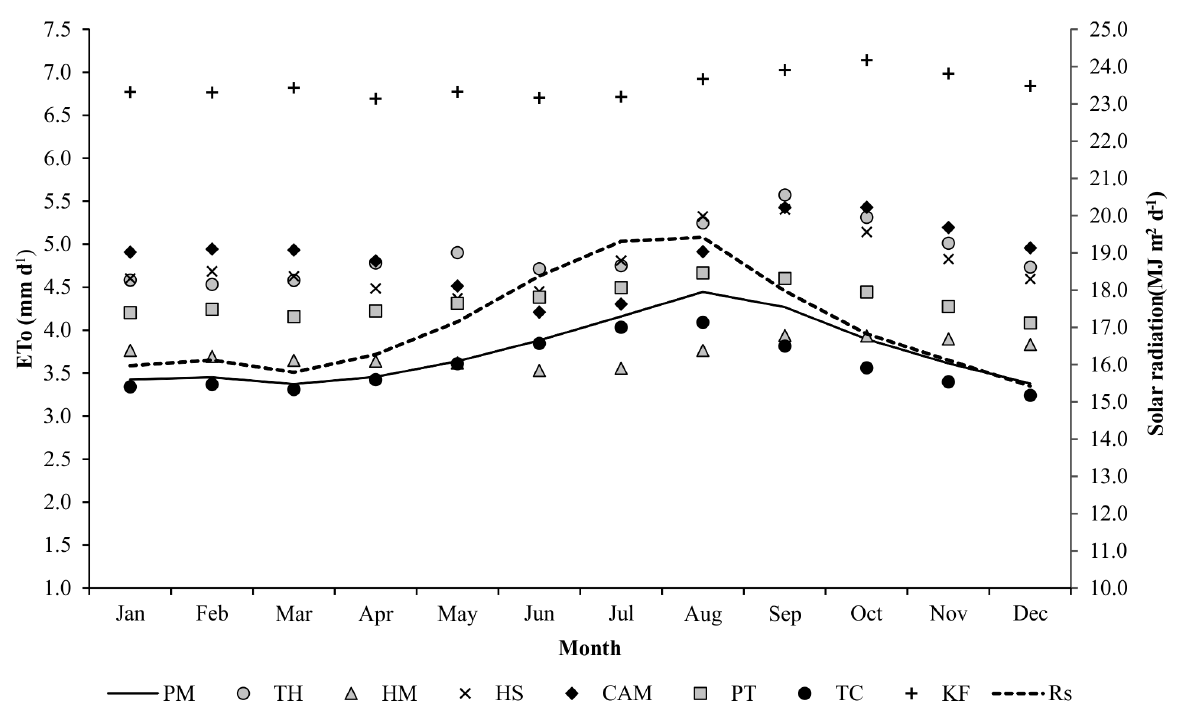
), in MJ m 2 . d -1 , throughout the year at IRW for s